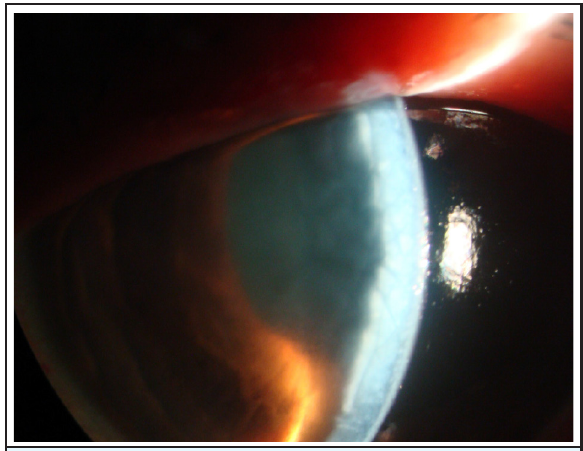
Figure 1. Corneal oedema with shallow anterior cham- ber in right eye.